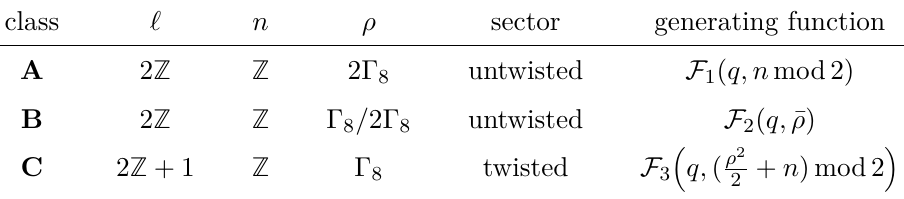
Table 8 . Classes of orbifold